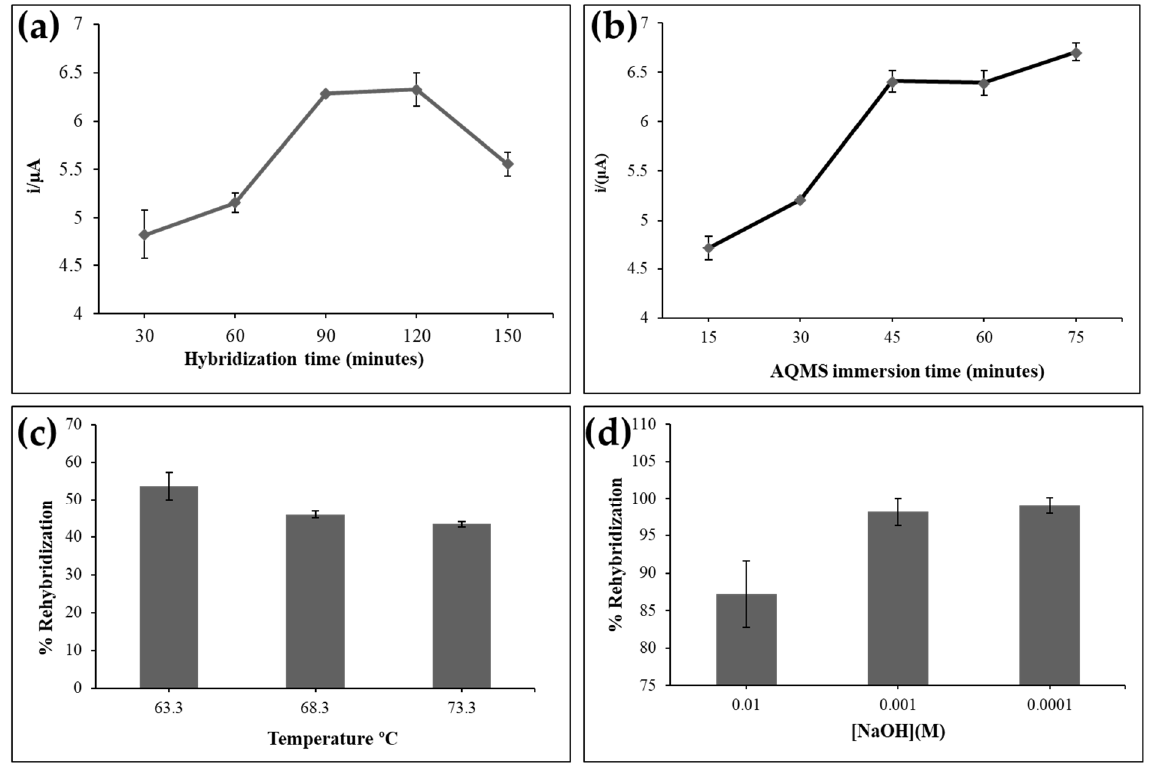
Figure 4. ( a ) The DNA biosensor response trend for a DNA hybridization period of 30–150 min